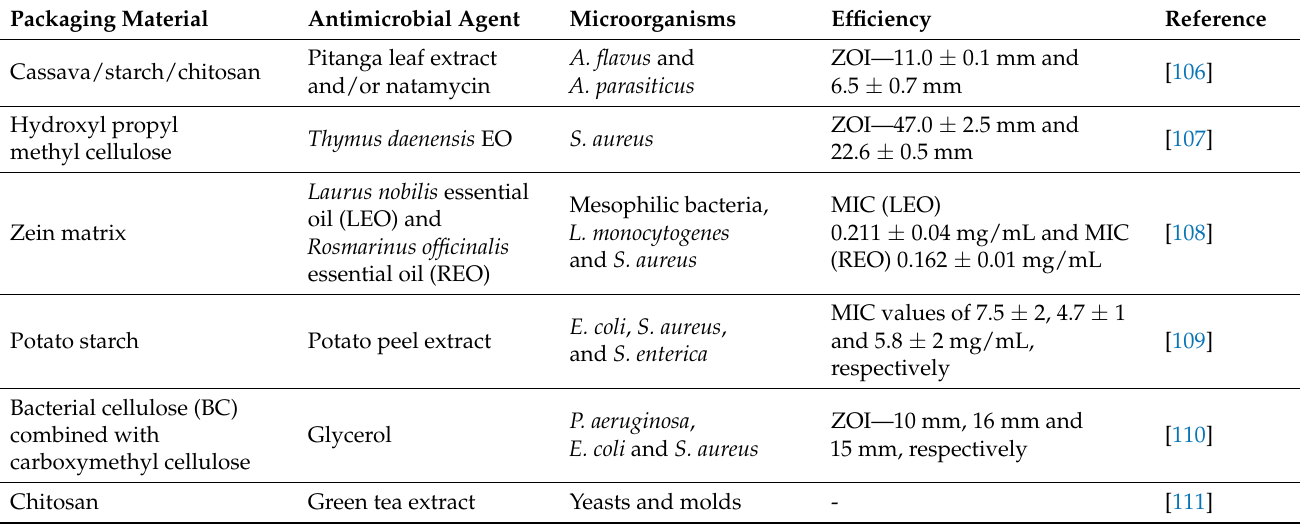
Table 3. Antimicrobial edible films against foodborne